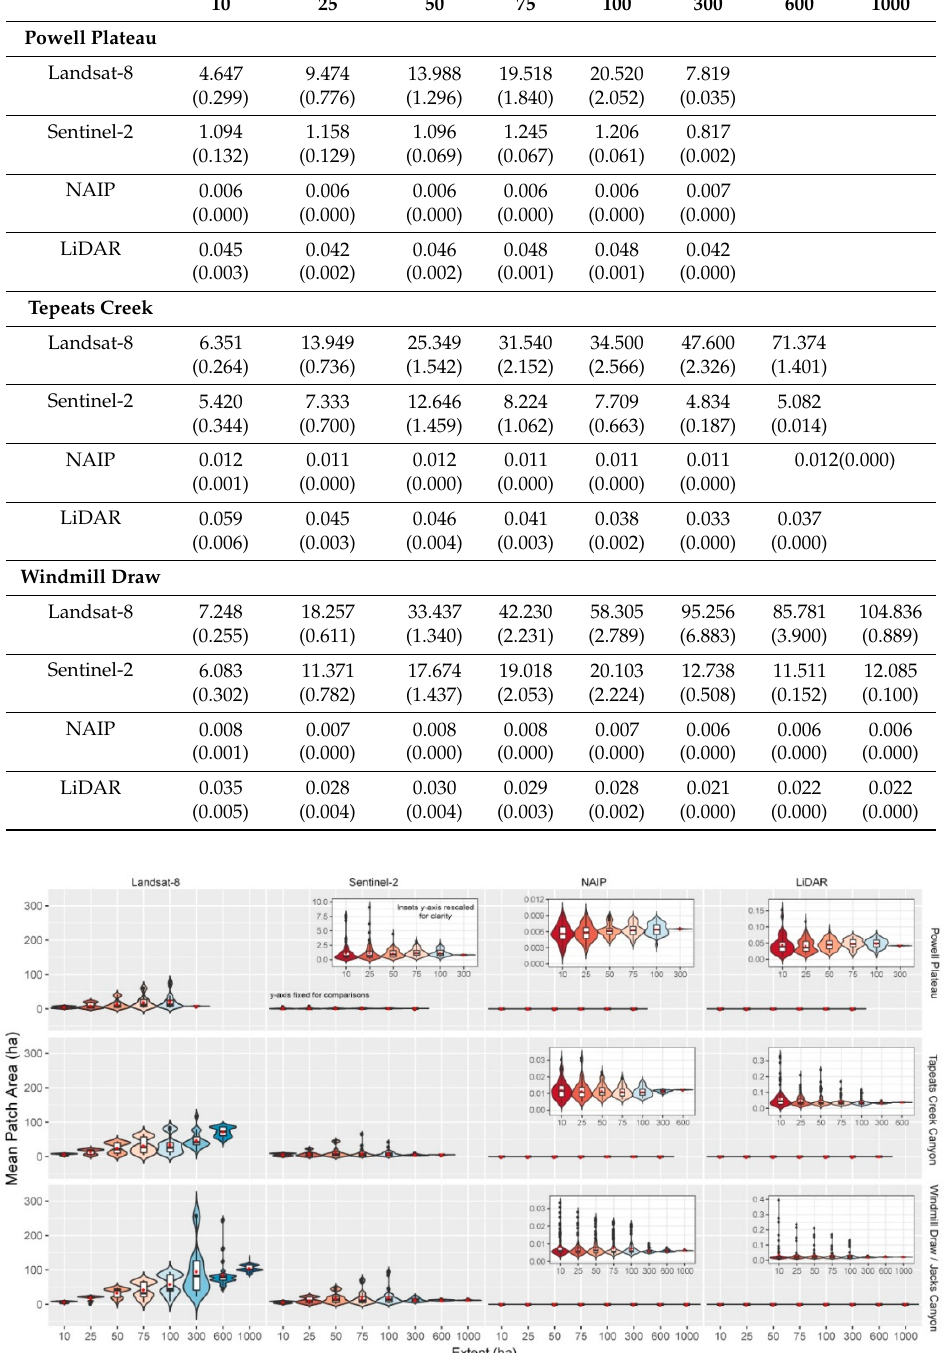
Figure 5. Violin plots (colored by extent and depicting probability density of the data at different values smoothed by a kernel density estimator), box-and-whisker plots (black and white), and mean (red dot) for mean patch area (ha) (average size of patches) for each landscape and data product (Landsat-8 30 m, Sentinel-2 10 m, NAIP 1 m, LiDAR 1 m), and across multiple spatial extents. Insets with rescaled y-axis provided for clarity.